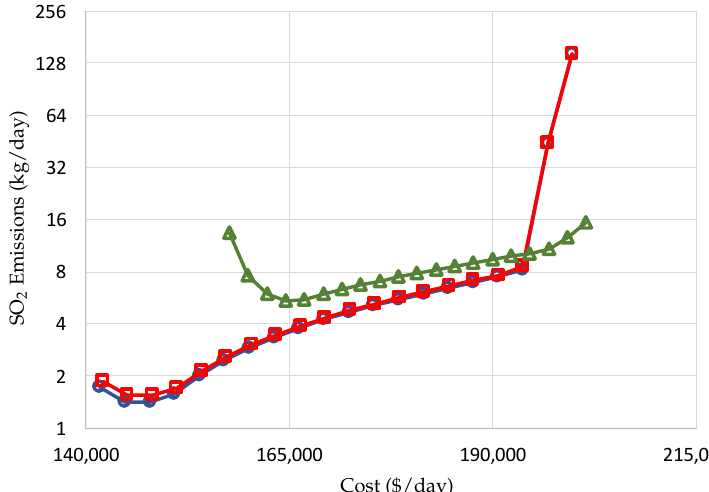
Figure 8. Cost vs. SO 2 Pareto set for Scenario 1 (– ◦ – blue), Scenario 2 (– (cid:3) – red), and Scenario 3 (– (cid:52) – green).